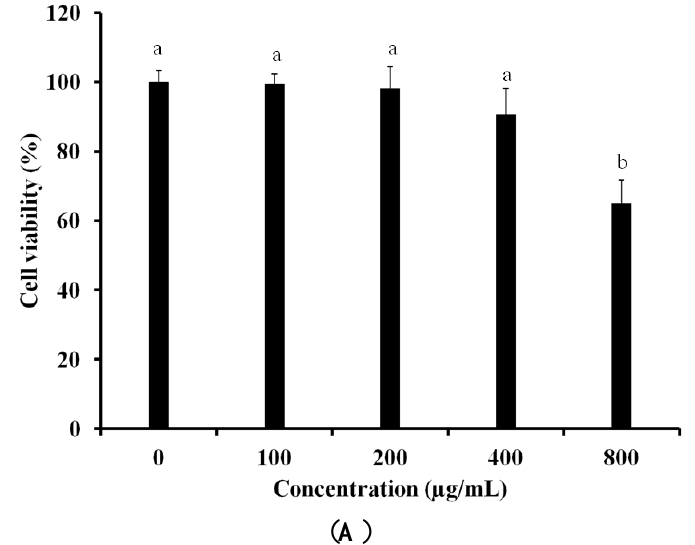
Figure 1. Cytotoxicity and anti-proliferative activity of Luffa echinata . ( A ) The CCD-986Sk cells were plated in 96-well plates and then exposed to 100, 200, 400, and 800 µg/mL of L. echinata extract for 24 h. With in a column, values with the same superscript letters are not significantly different from each other at p < 0.05; ( B ) HepG2 and HT-29 cells were plated in 96-well plates and then exposed to 50, 100, and 200 µg/mL of L. echinata extract for 24 h. The cell viability of HT-29 cells treated by L. echinata extract was measured using an MTT assay. a–c indicated the statistical significance of the anti-proliferative activity of various concentrations of LER extract on HepG2 cells ( p < 0.05). A–D indicated the statistical significance on HT-29 ( p < 0.05); ( C ) HT-29 cells were incubated with 50, 100, and 200 µg/mL of L. echinata extract for 6, 12, 24, 48, 72 h, respectively. The cell viability of HT-29 cells treated by L. echinata extract was measured by MTT assay. ( D ) Cell culture morphology was assessed by light microscopy after incubation with various concentrations of L. echinata extract for 24